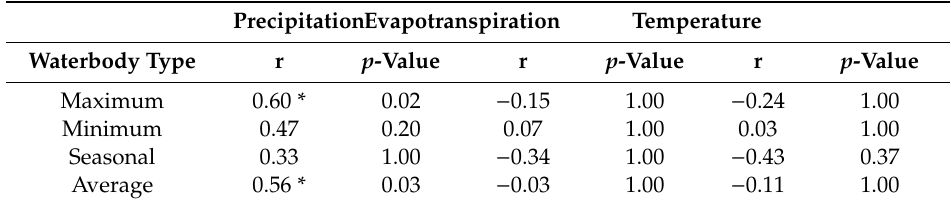
Table 2. Statistical summary of the linear correlation between the precipitation, evapotranspiration, temperature and the Huai River Basin’s water body area from 1989 to 2017.